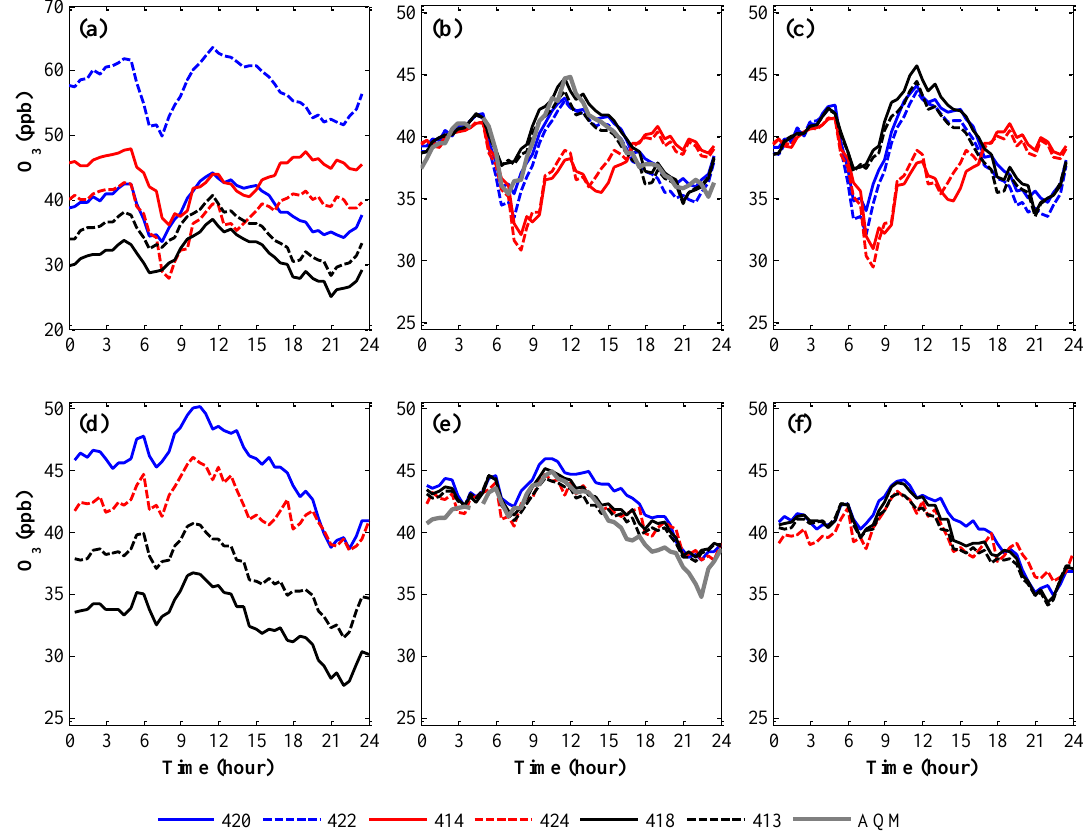
Figure 1. Daily patterns of 30 min. average O 3 concentrations during weekdays (Sunday to Thursday; upper row) and Saturdays (lower row) ( a , d ) before calibration; ( b , e ) after calibration against a nearby AQM measurements from 1:00 to 4:00 am; ( c , f ) and after calibration against the mean half-hourly reading between 1:00 and 4:00 am of all the WDESN nodes. (Reproduced with permission from [19]).